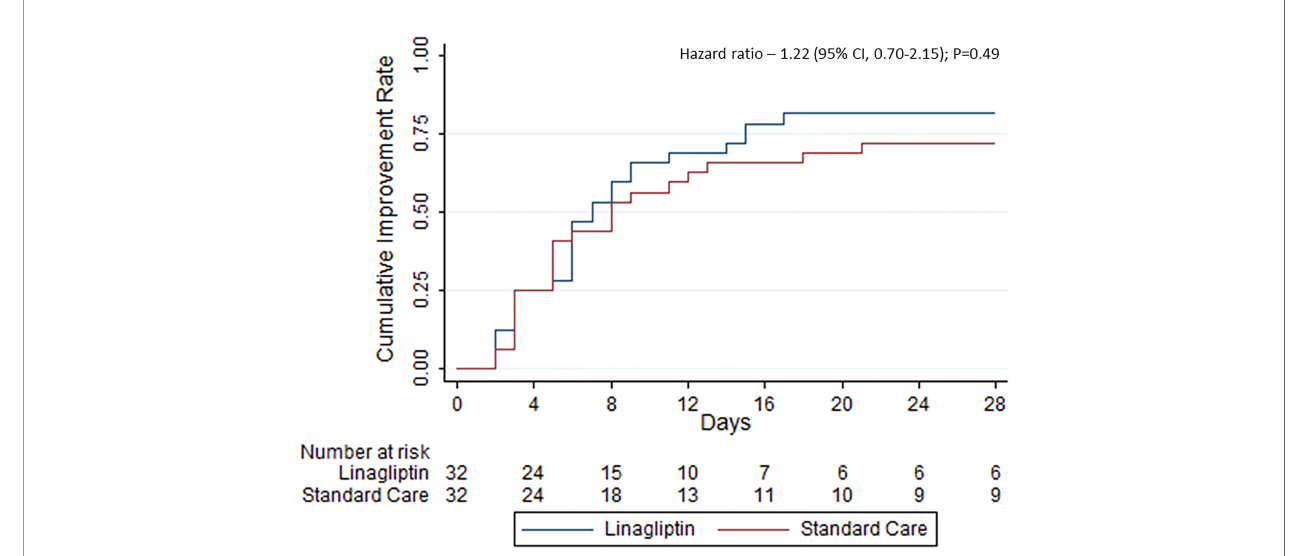
FIGURE 2 | Kaplan – Meier estimates of cumulative clinical